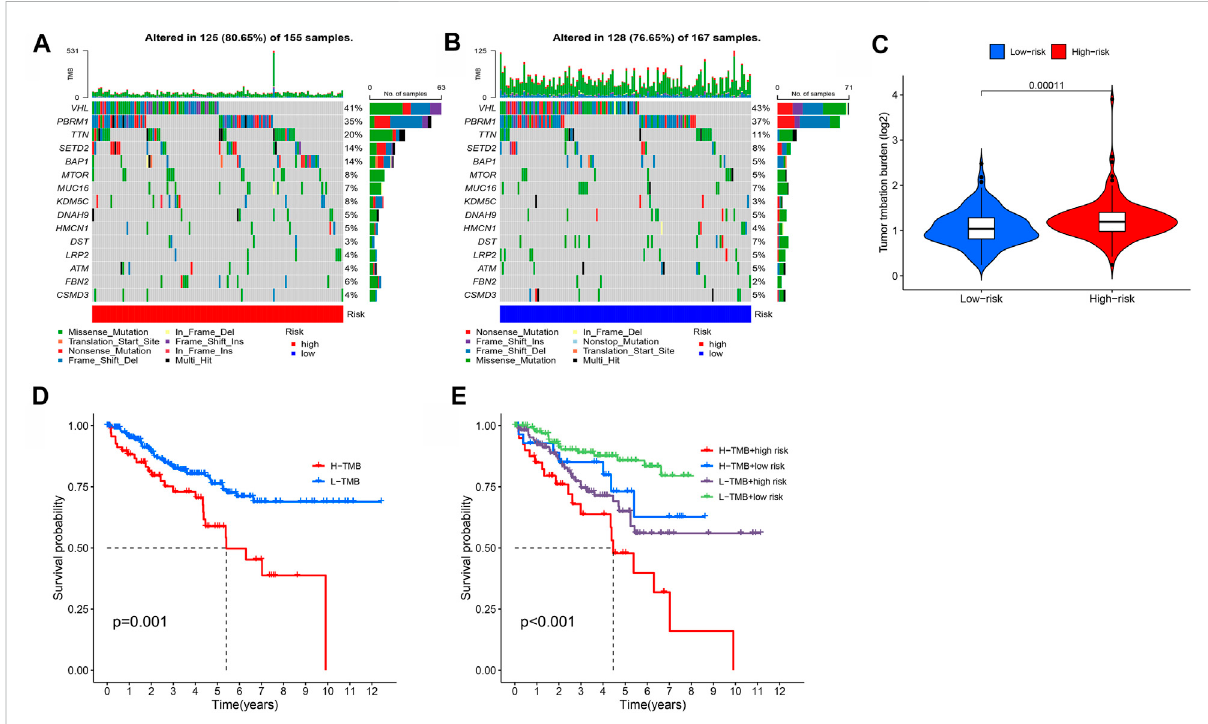
FIGURE 9 Investigation of tumor mutation burden (TMB). (A,B) TMB in high- and low-risk groups, respectively. (C) Comparison of TMB between two groups. (D,E) Survival curve strati fi ed by TMB and risk